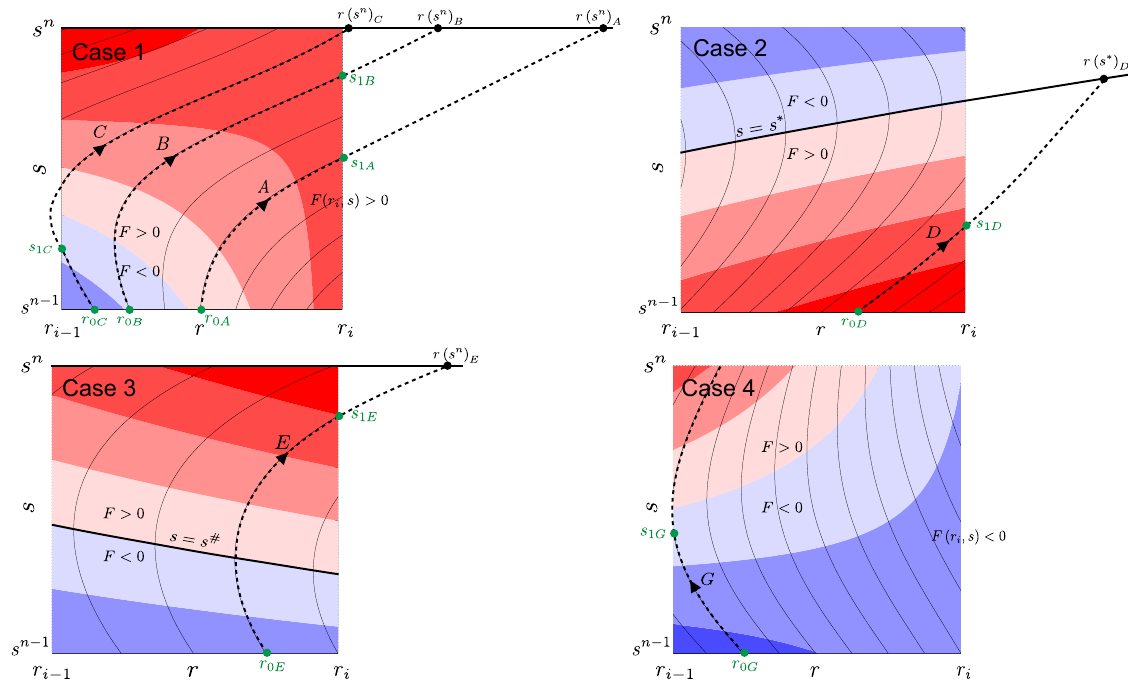
Figure 3. The four different cases of how trajectories might reach the grid face at r = r i . Note that the trajectories for case 4 can not reach r = r i . The background colours are the same as in Fig. 2 with F > 0 in red and F < 0 in blue. The dashed trajectories outside the grid box denote the necessary computed fictive paths for estimating when s = s 1 and if the trajectories reach r 1 (s 1 ) = r i